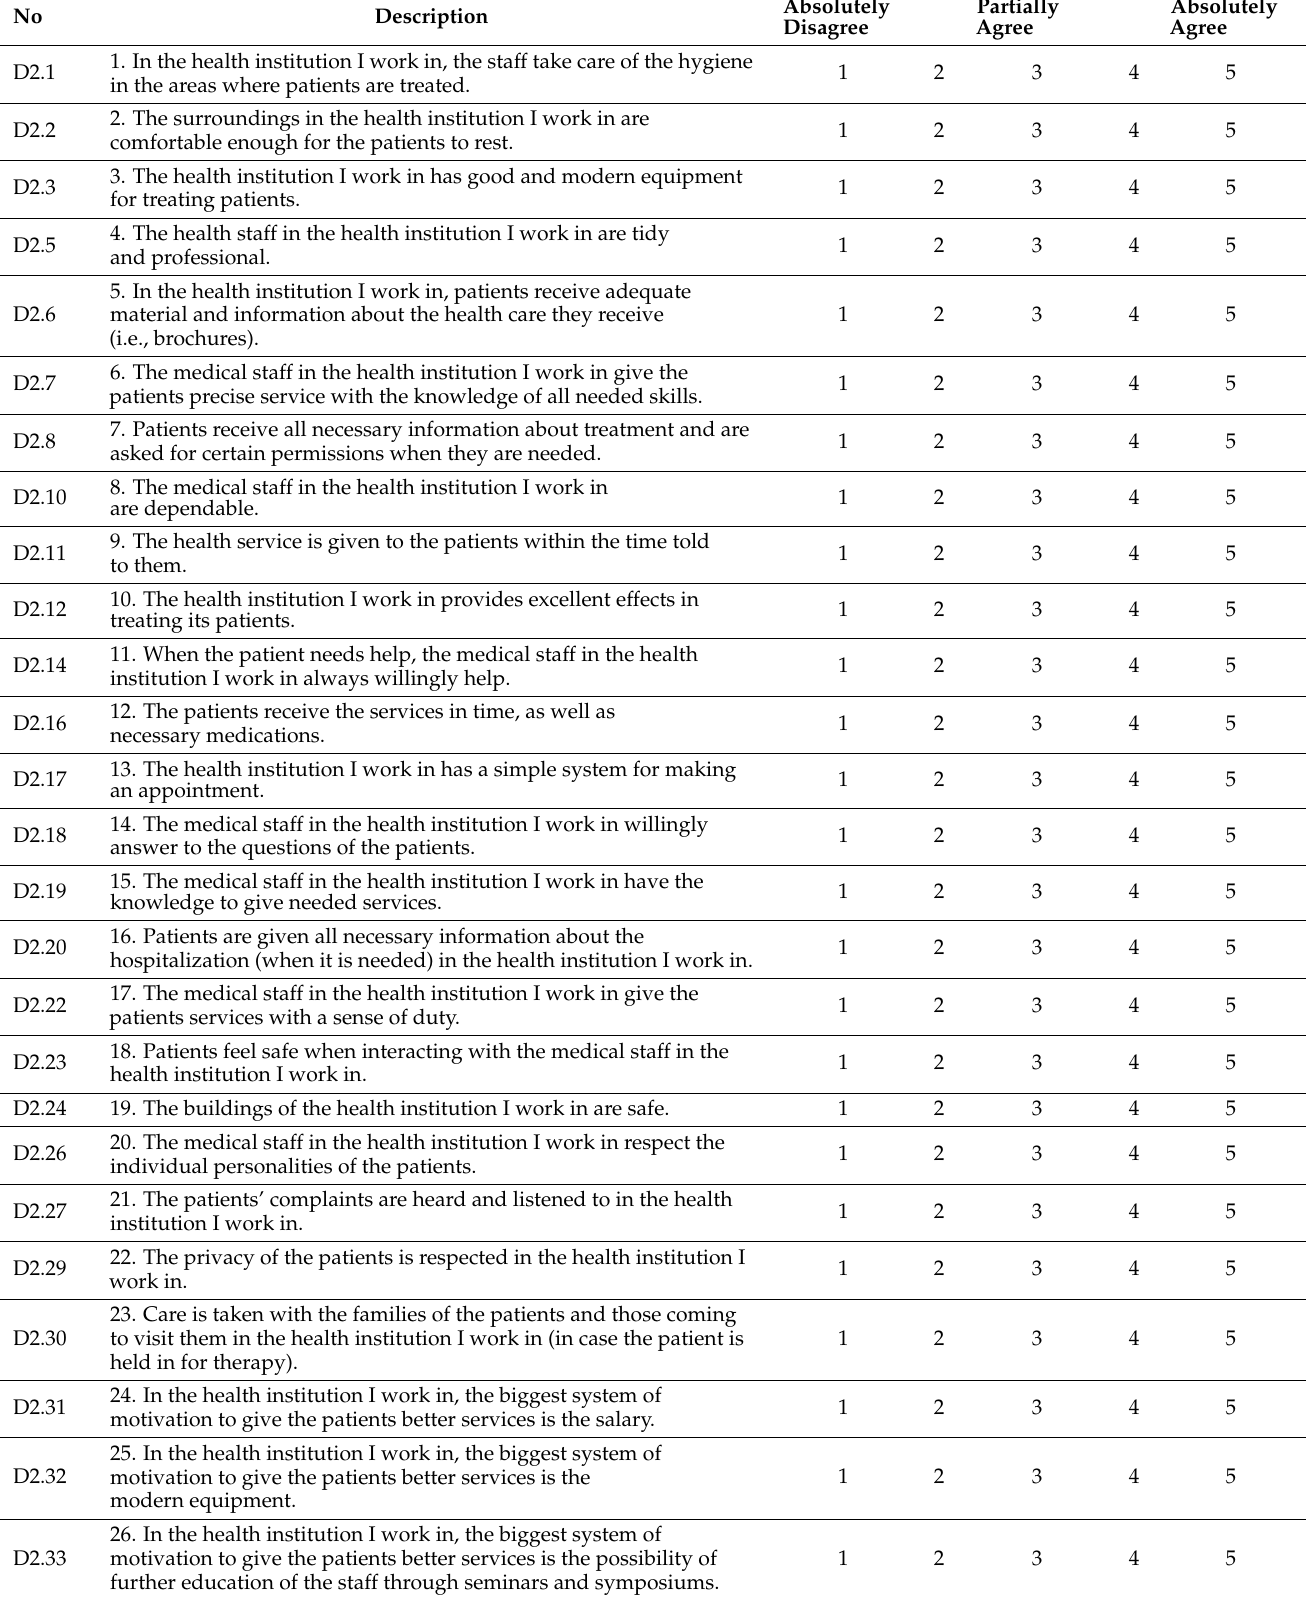
Table A2. Perception of the staff of the quality of given health services in the health